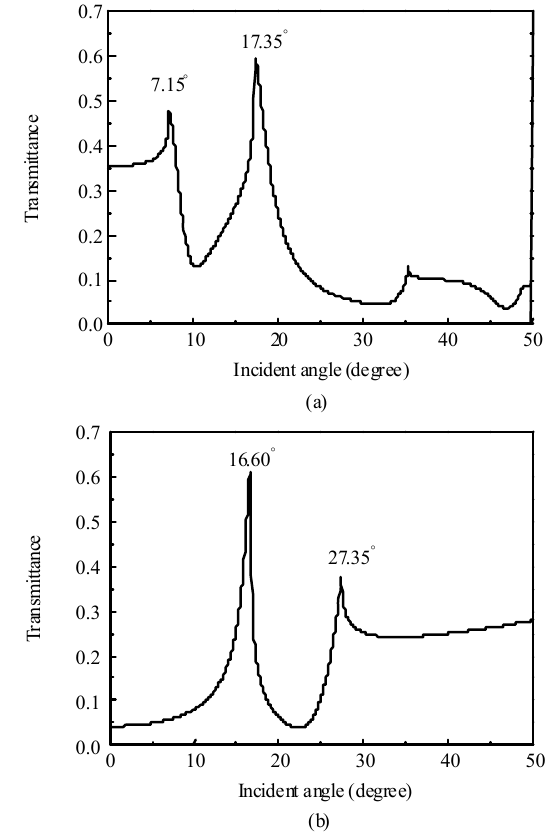
Fig. 2 Simulation results for the transmittance as a function of the incidence angle for a mixed solution of 1-iodonaphthalene and sulfur. Grid periods of (a) 500 nm and (b) 300